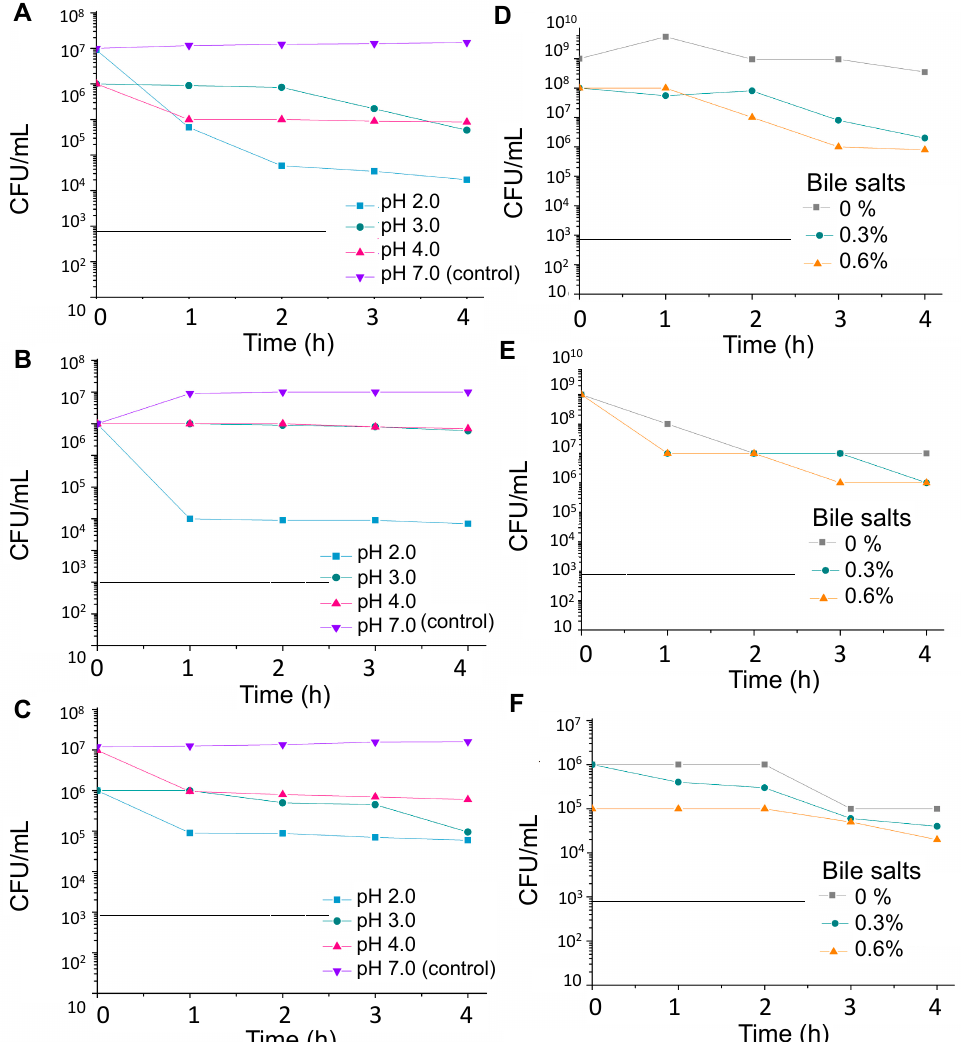
Figure 1. Stress tolerance of selected microbial strains isolated from a honey-based kefir beverage. Acid tolerance of Lactobacillus satsumensis LPBF1 ( A ), Leuconostoc mesenteroides LPBF2 ( B ) and Saccharomyes cerevisiae LPBF3 ( C ); bile salt tolerance of Lactobacillus satsumensis LPBF1 ( D ), Leuconostoc mesenteroides LPBF2 ( E ) and Saccharomyes cerevisiae LPBF3 ( F ). The dotted line is the detection limit.